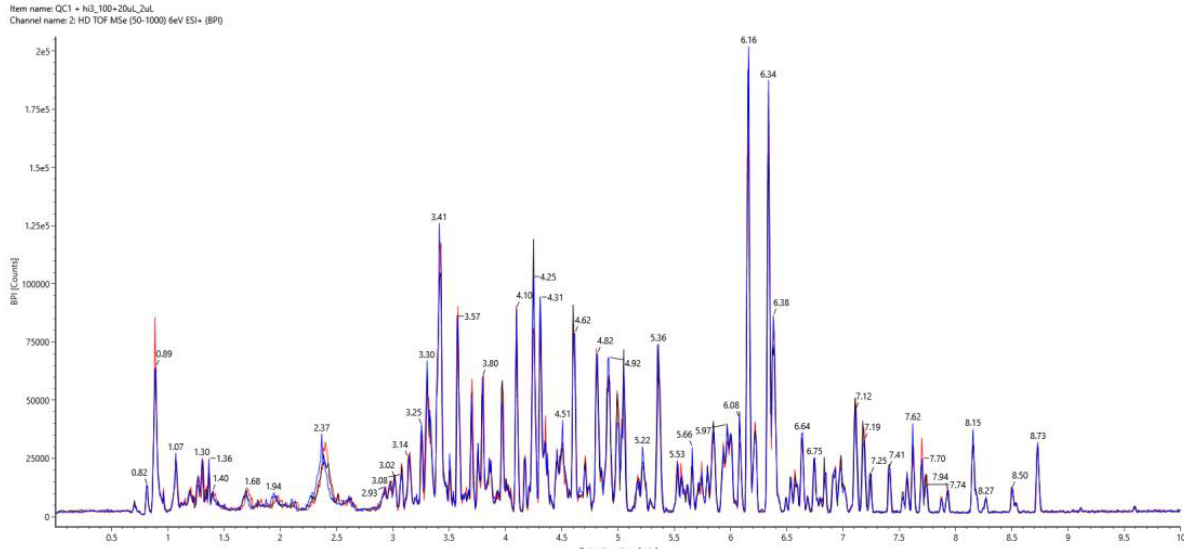
Figure 1. Overlay of triplicate injection of Hi3 E.coli STD spiked pooled-sample base peak intensity (BPI) chromatograms.